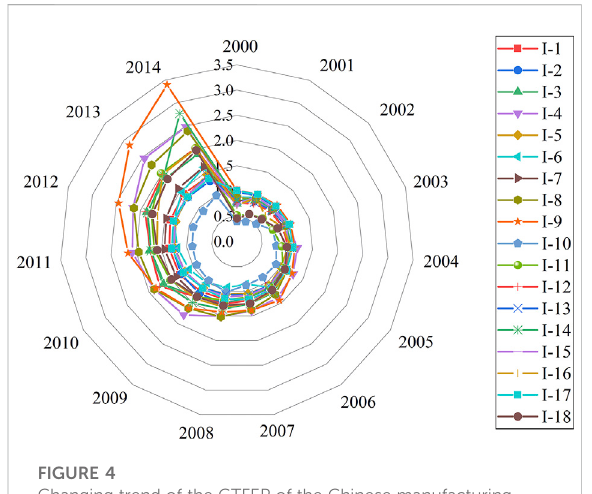
FIGURE 4 Changing trend of the GTFEP of the Chinese manufacturing industry (2000 – 2014).